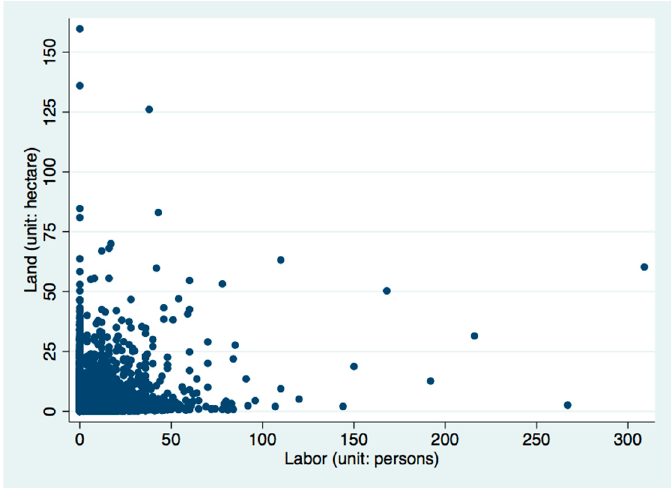
Figure 2. Scatter plot with labor and land .